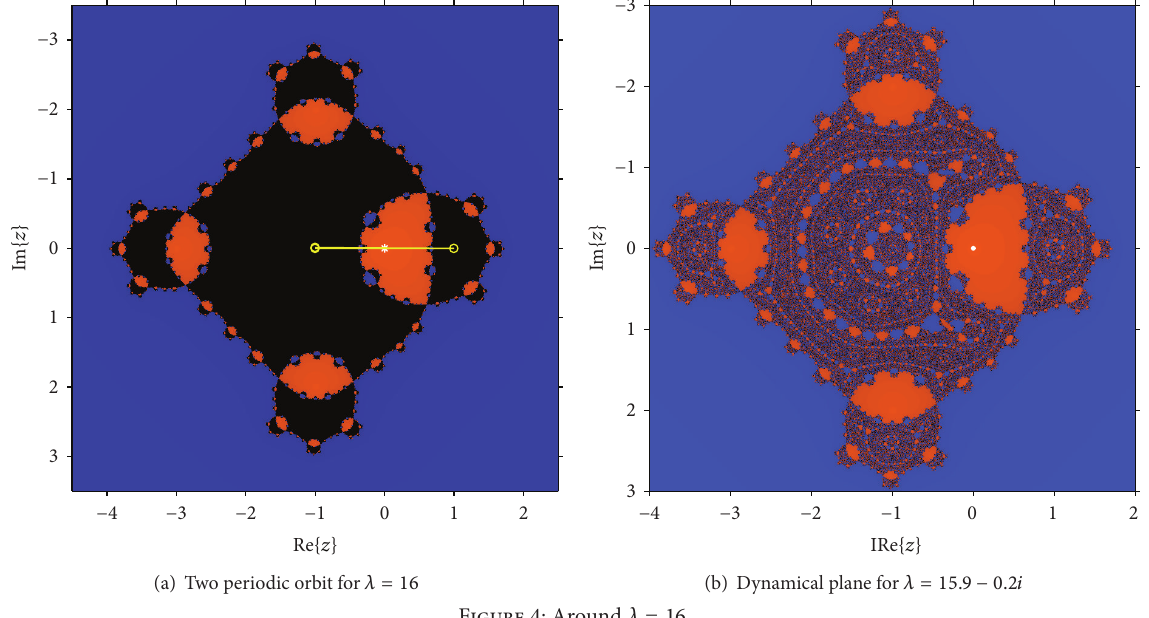
Figure 4: Around 𝜆 = 16 .